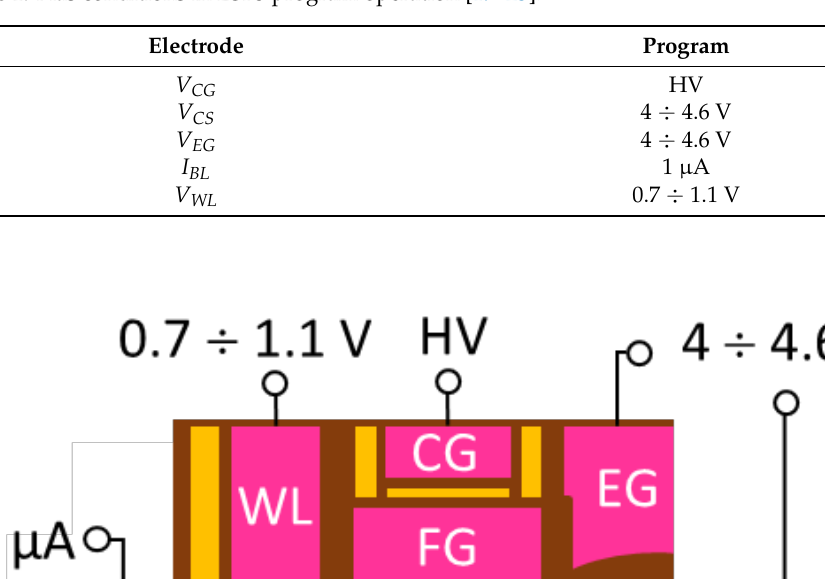
Table 1. Bias conditions in ESF3 program operation [19–23].